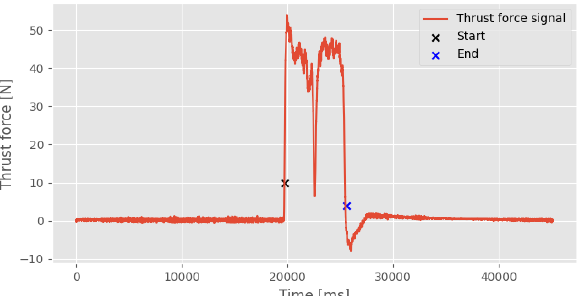
Figure 3. An example of thrust force signal segmentation for the first hole of the experimental test